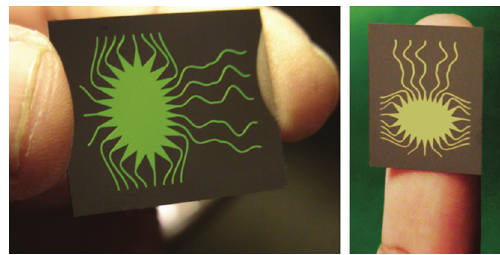
Figure 16: Fabricated Rotman lens.